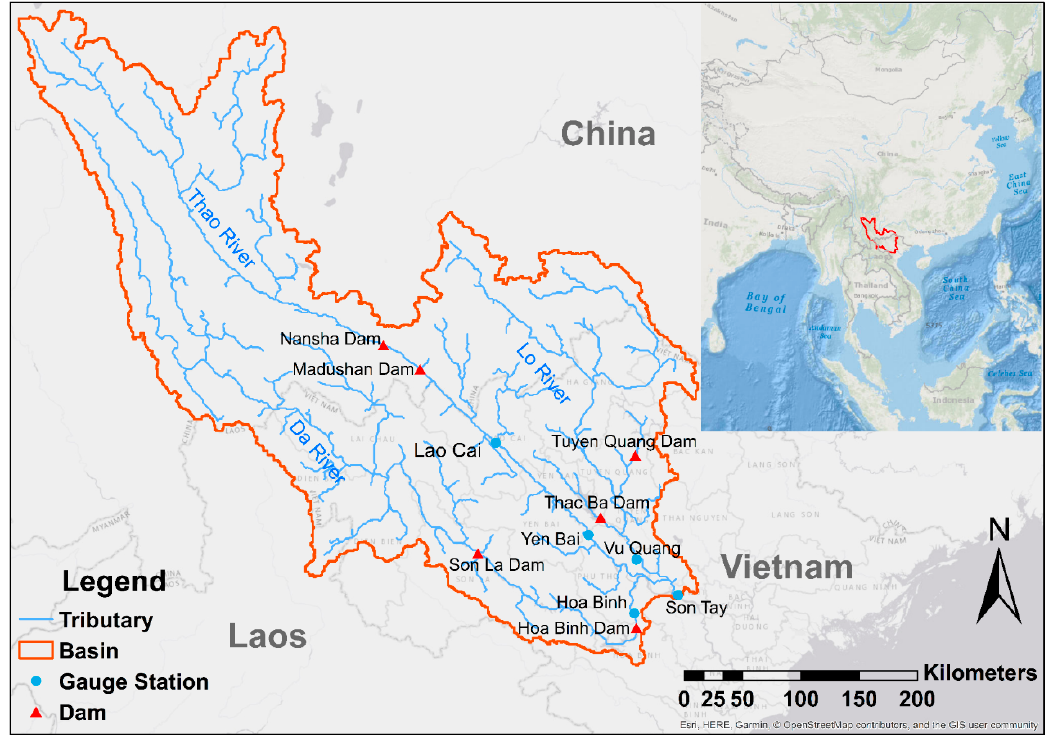
Figure 1. Map of the Red River basin: geographical location of study area in Asia; hydrological gauge stations and dams.